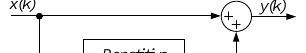
Figure 13. A resonant controller’s response vs. 𝑘 0 .